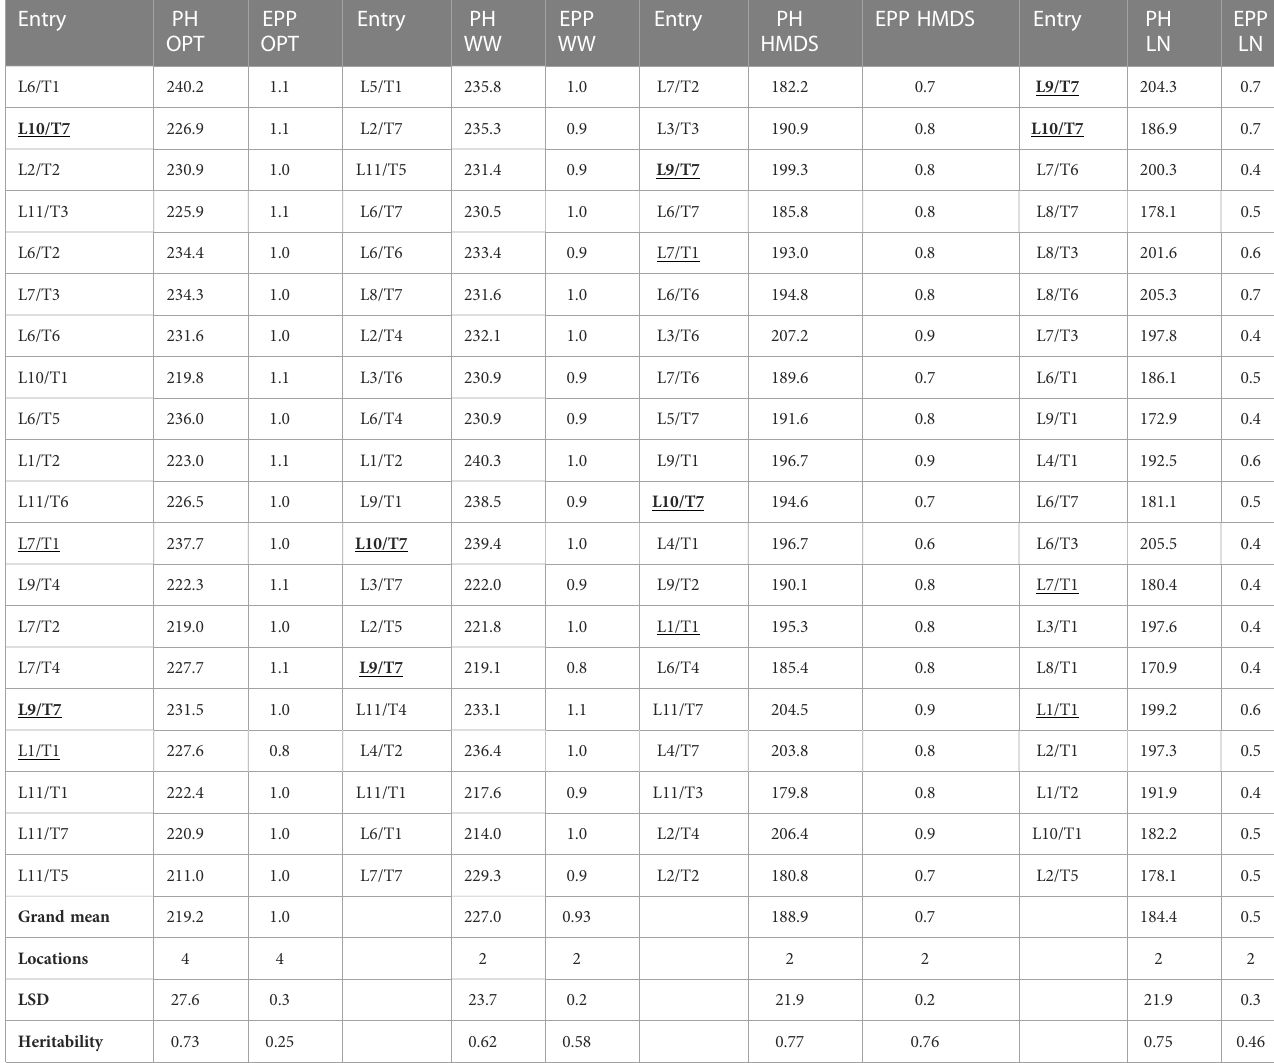
TABLE 4 Plant height (cm), and number of ears per plant of the top 20 hybrids under different management conditions. Entry PH